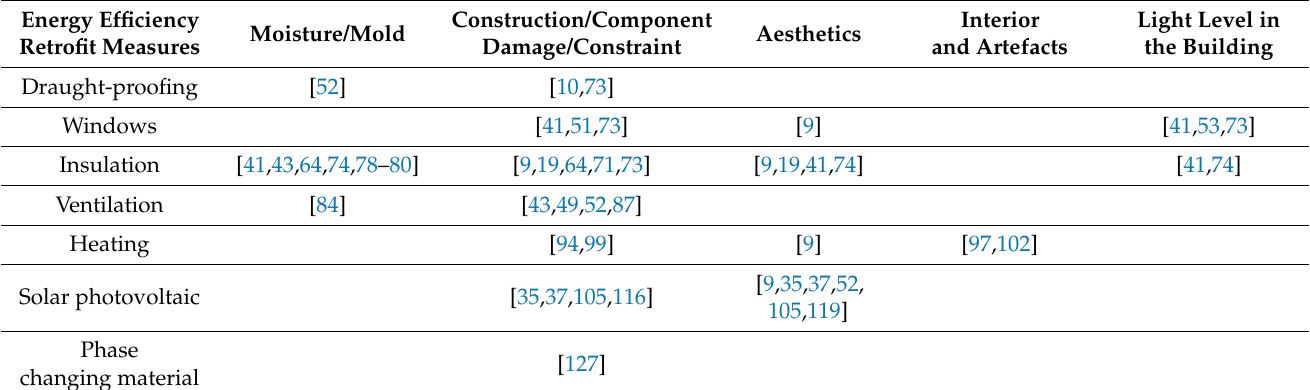
Table 2. Literature references suggesting challenges to be aware of for the reviewed renovation strategies to reduce energy use in heritage